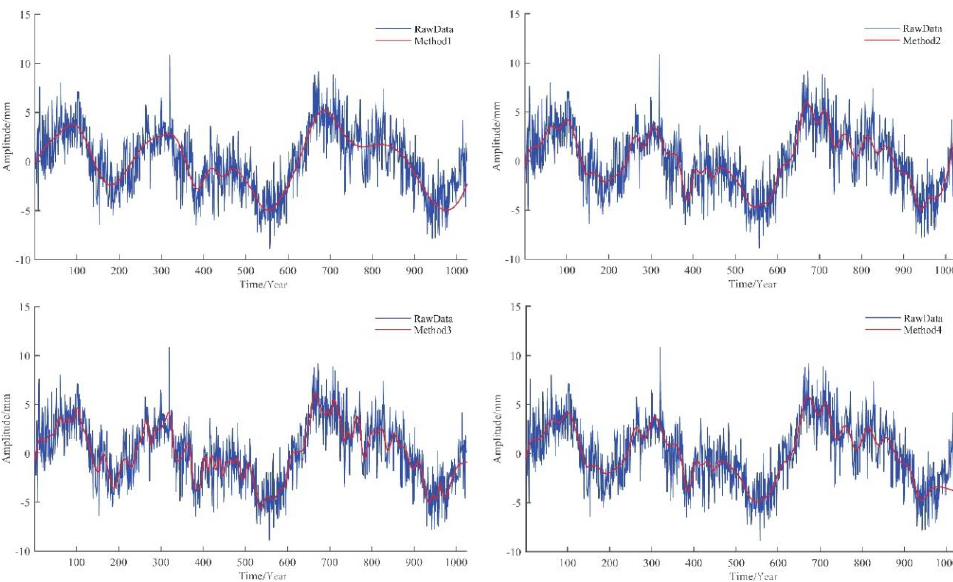
Figure 13. Signal sequence graph of simulation data I after noise reduction in different methods.